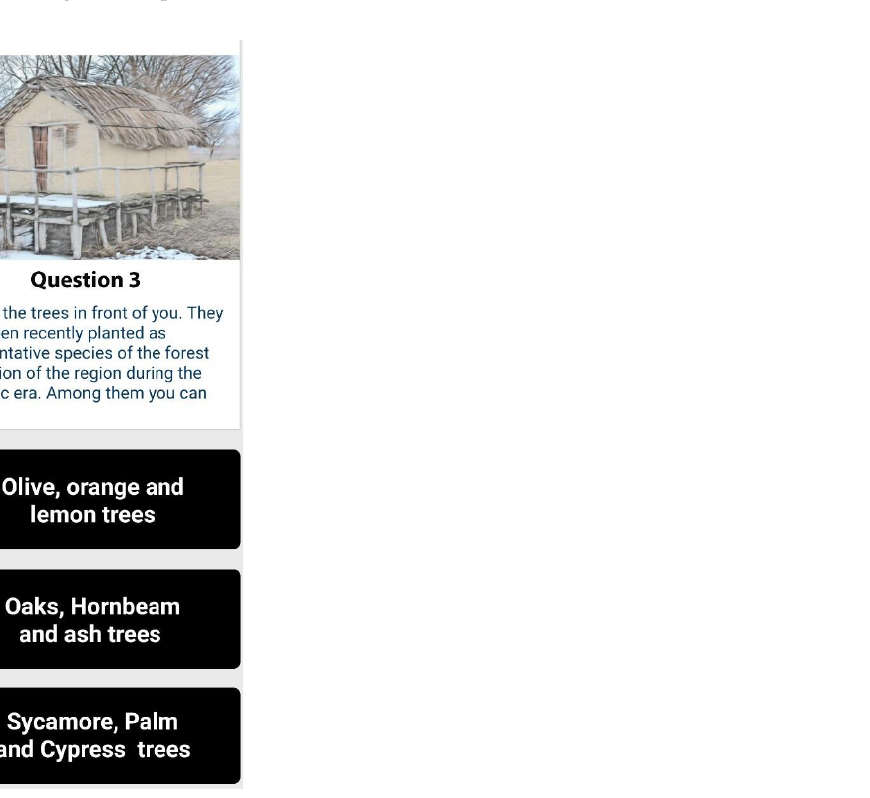
Figure 6. Navigation map.